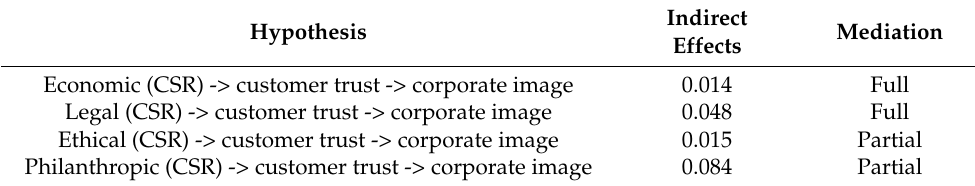
Table 5. Hypotheses and Mediating